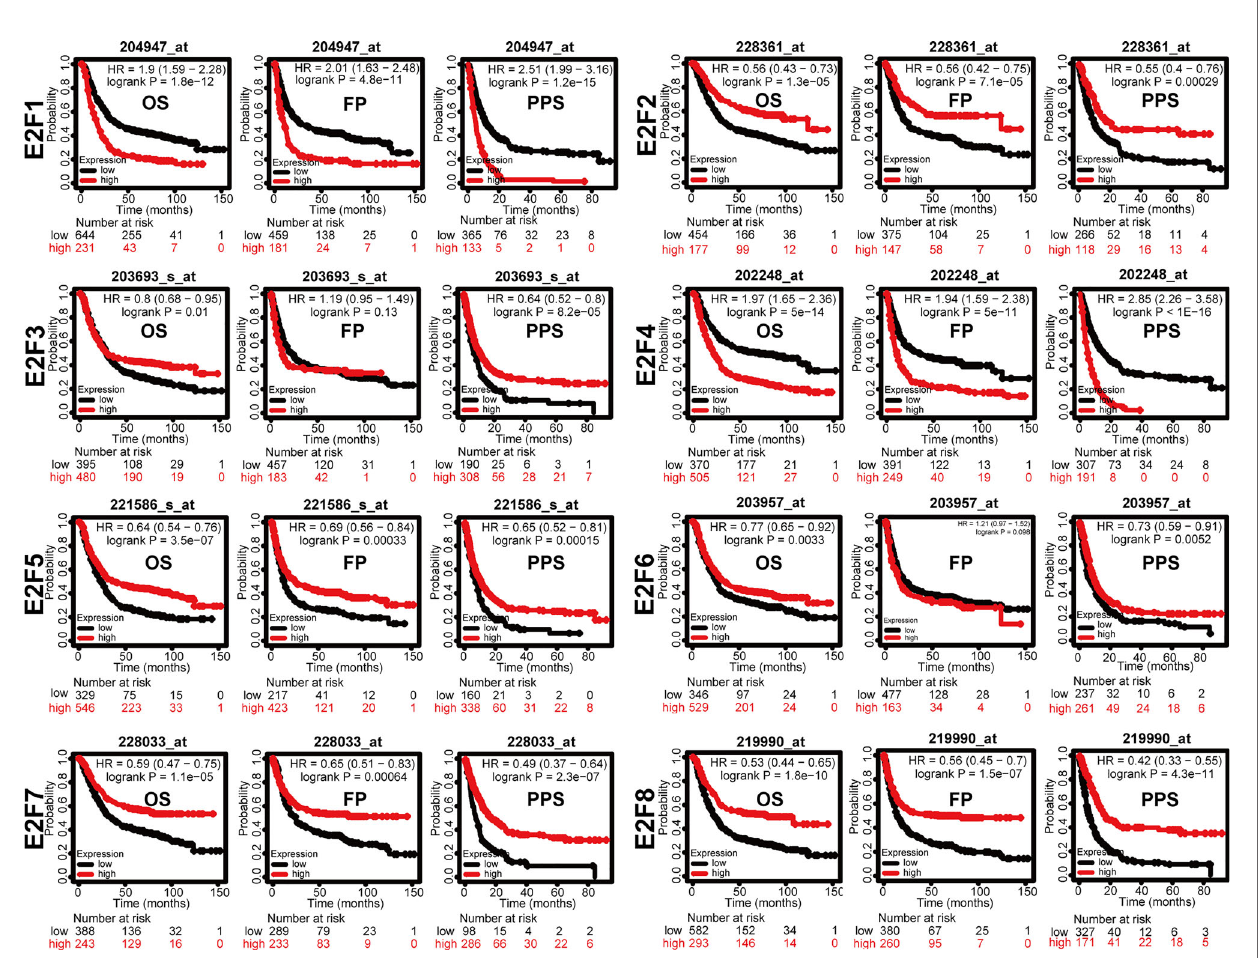
FIGURE 5 | Prognostic value of mRNA expression of E2Fs in GC patients (Kaplan-Meier Plotter). Overall survival curve, progression-free survival, and post- progression survival curve of GC patients were plotted. The JetSet best probe set was used as the probe set option. Patients were split by the auto selected best cutoff. If the expression level was higher than the cutoff value, the OS curve was marked as high; if the expression level was lower than the cutoff value, the OS curve was marked as low. The cutoff for signi fi cance was set to p < 0.05. OS, overall survival; FP, fi rst progression; PPS, post-progression